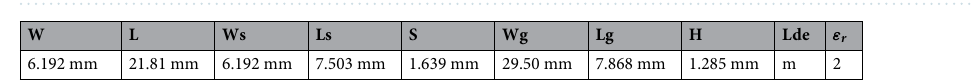
Table 2. Detailed dimension of the 3.5 GHz antenna. *Length, breadth, and width of the antenna substrate are 21.86 mm, 21.81 mm, and 1.285 mm, respectively.